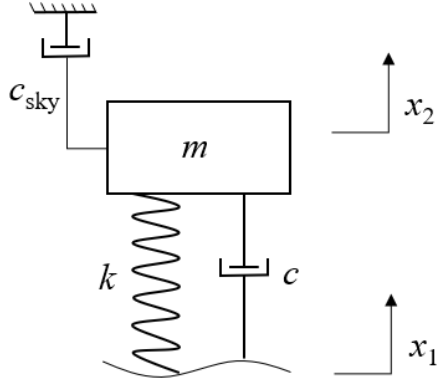
Figure 21. The ideal skyhook control model.